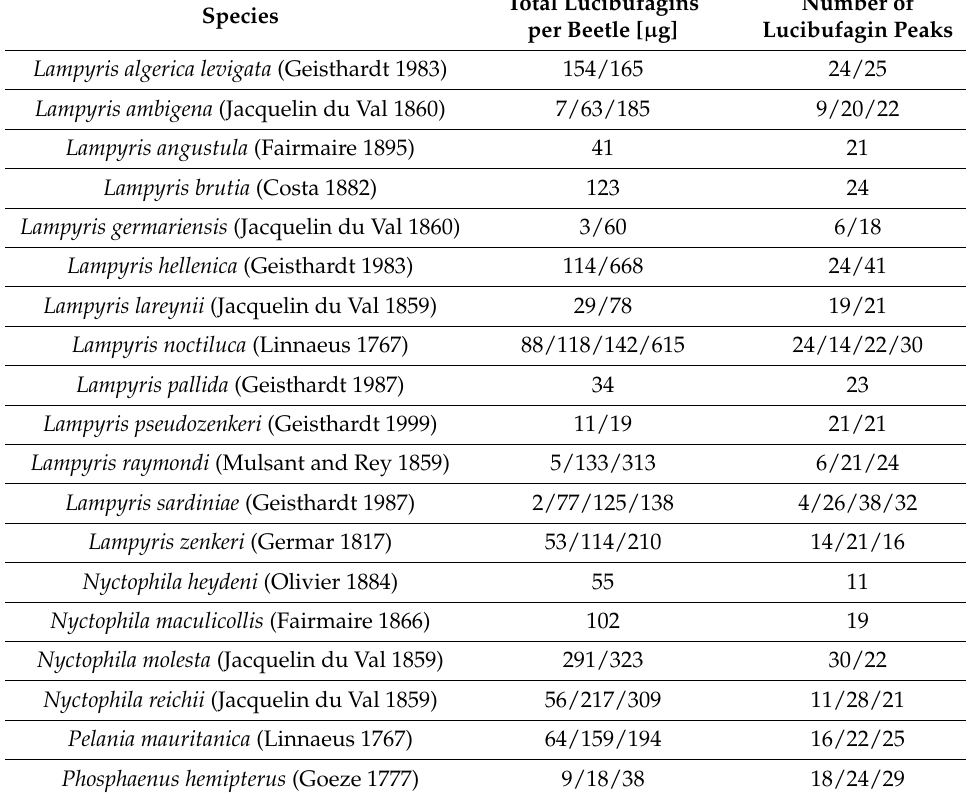
Table 1. Total amounts of lucibufagins and diversity of structurally different lucibufagins based on HPLC-DAD. Individual lucibufagin contents are separated by slashes if more than one specimen was analyzed (second column). Diversities of individual lucibufagins (third column) are listed in the same manner. Note that only positively screened species are listed in the